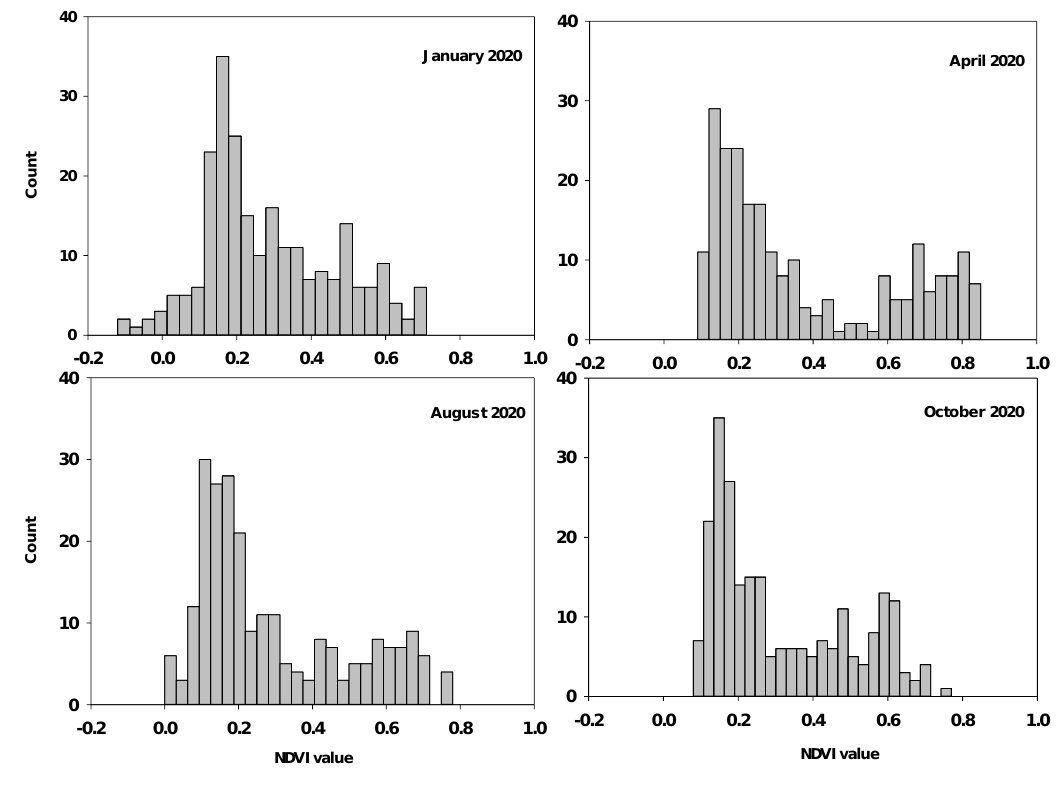
Figure 6. Histogram showing distributions of greenness from vegetation for four periods of 2020 in the High Atlas Mountains of Morocco. NDVI was calculated from Landsat 8 (USGS). Table 5. Statistics of NDVI values for the High Atlas Mountains of Morocco in four periods of 2020. The NDVI was calculated from Landsat 8 data. To separate means a pairwise multiple comparison procedure (Holm – Sidak Method) was used (n = 239).